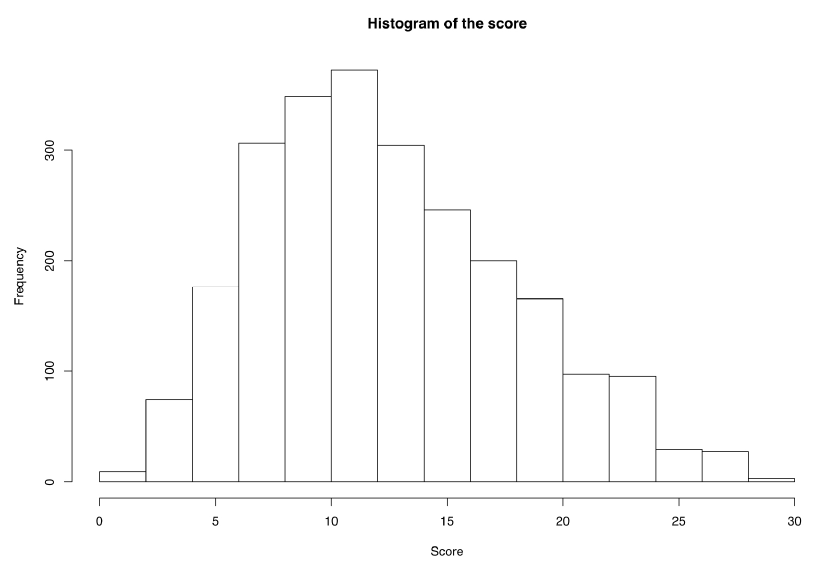
Figure 1 – The histogram of the